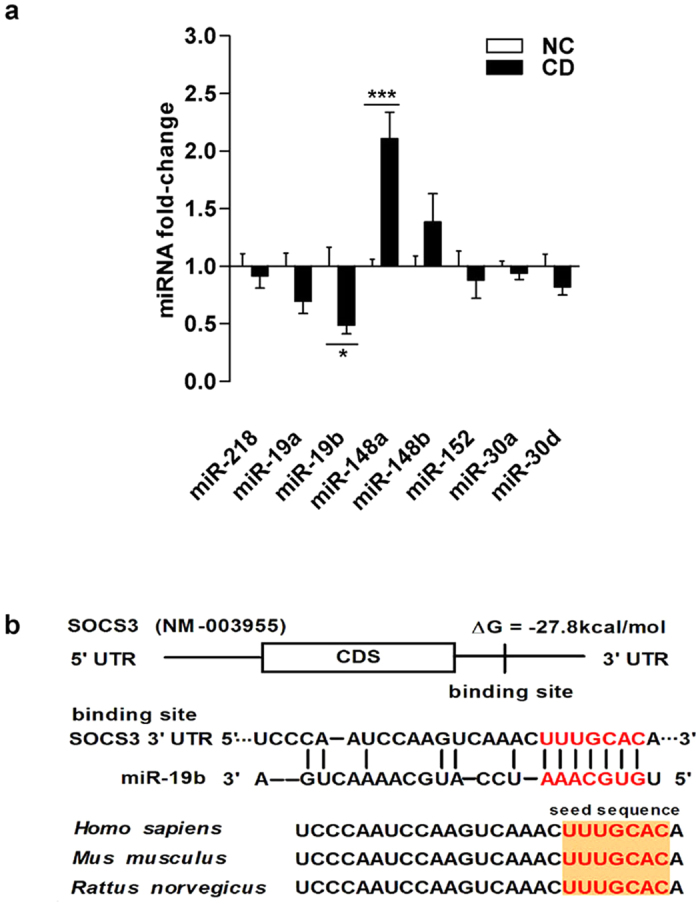
The SOCS3 3’-UTR contains conserved miR-19b target sites. (a), The fold-changes of eight miRNAs predicted by three algorithms in CD intestinal tissues compared to controls, as analysed by qRT-PCR (n = 20 per group; *p = 0.012, miR-19b group;***p = 0.000395, miR-148a group). (b), Schematic illustration of conserved duplexes formed by SOCS3 3’UTR and miR-19b interactions. The predicted free energy of the hybrid is noted. The predicted structure of the base-paired hybrid is shown. Paired bases are marked by a black line. Sequence alignment of the putative miR-19b binding sites across species is shown. The complementary seed sites are marked in red, and all nucleotides in these regions are conserved among several species, including human, mouse and rat.